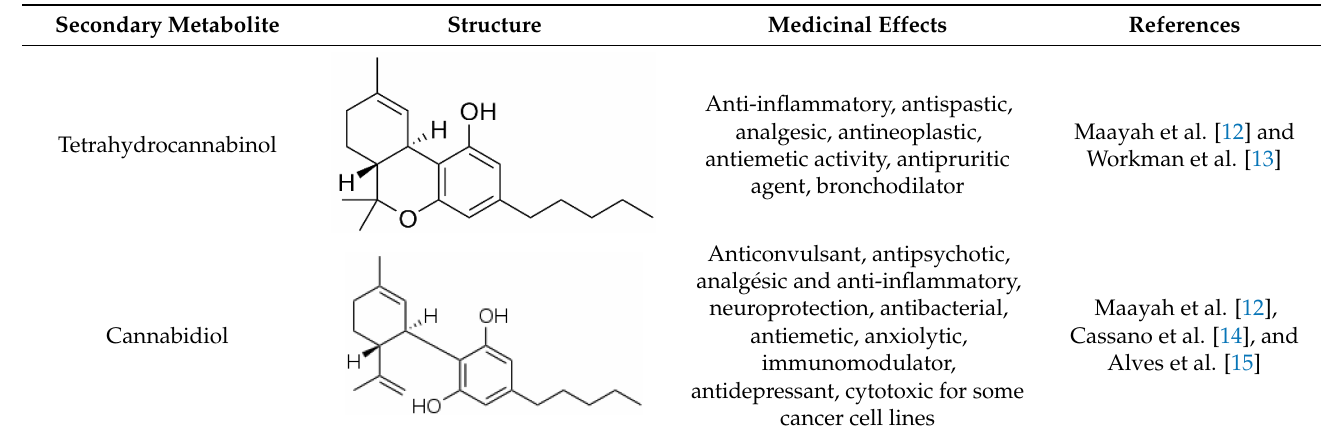
Table 1. Some pharmacological properties of